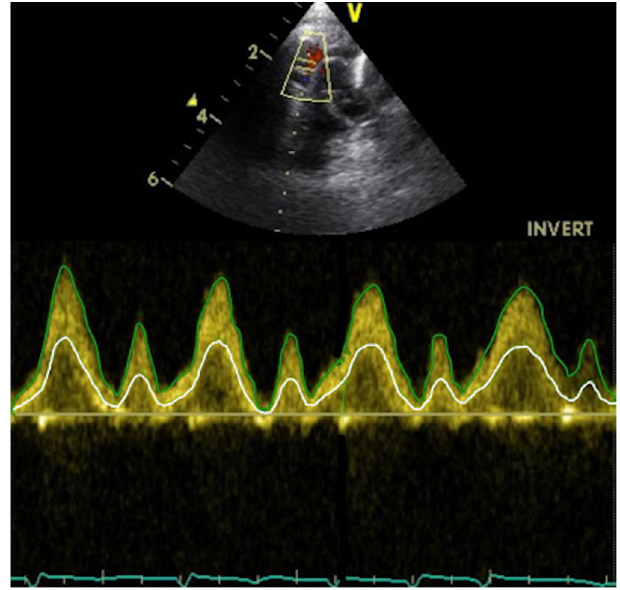
Figure 3. Spectral Doppler profile of blood flow velocity in the SVC, assessed from a suprasternal view. The green line represents the peak blood flow velocity, the white line the mean blood flow velocity.